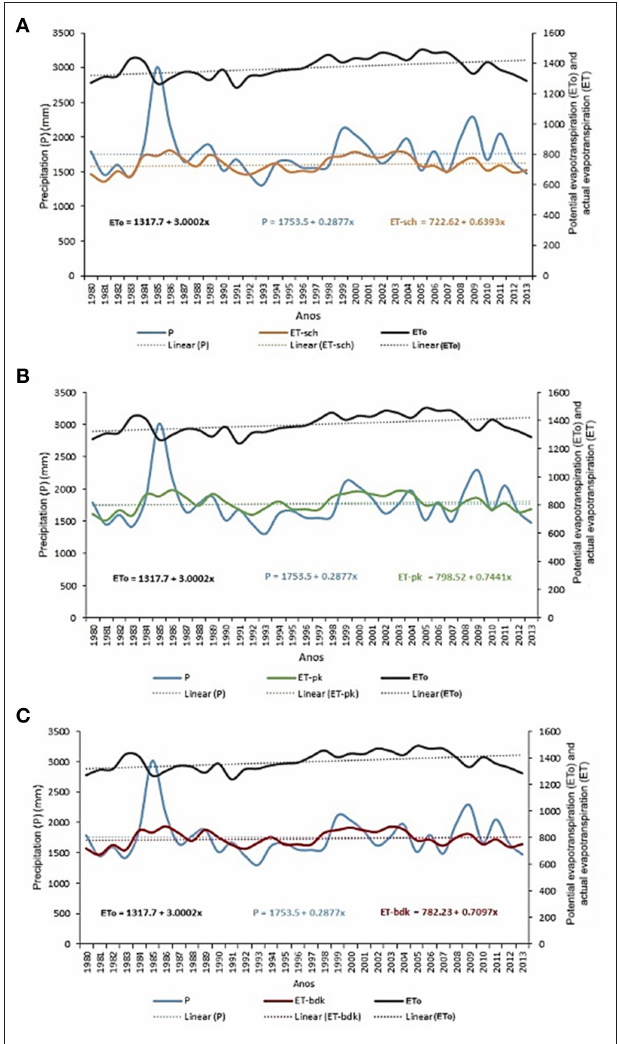
FIGURE 4 | Long-term (annual) behavior of precipitation (P), potential evapotranspiration (ET o ), and actual evapotranspiration (ET) estimated by the equations of (A) Schreiber (1904), (B) Pike (1964), and (C) Budyko (1974). The dotted lines represent the trends for each